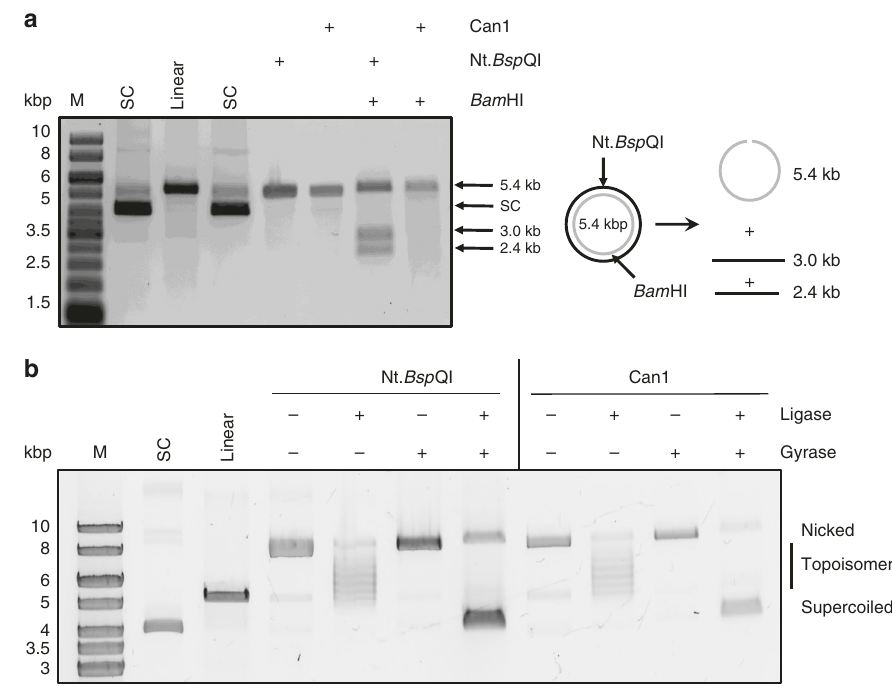
Fig. 5 Can1 nicks plasmid DNA at random sites, leaving ligatable DNA ends. a Plasmid nicking by the Nickase Nt. BspQ I and Can1 were analysed by alkaline agarose gel electrophoresis where all DNA is denatured into single-stranded products. Both generate linear 5.5 kb products. When Nt. BspQ I nicking at its recognition site is followed by Bam HI digestion, the expected linear products of 3.0 and 2.5 kb are also observed. Can1, which nicks at random sites, generates a wide range of linear products following Bam HI digestion that appear as a smear in the gel. b Both the Nickase Nt. BspQ I and Can1 nick supercoiled plasmid to yield open circle DNA that can be visualised following agarose gel electrophoresis. Ligation of these products by DNA ligase generates closed circular DNA with a range of topoisomers. Addition of DNA gyrase restores the supercoiled DNA substrate. Control lanes are as for Fig. 4. Source data are provided as a ‘ Source Data ’ fi